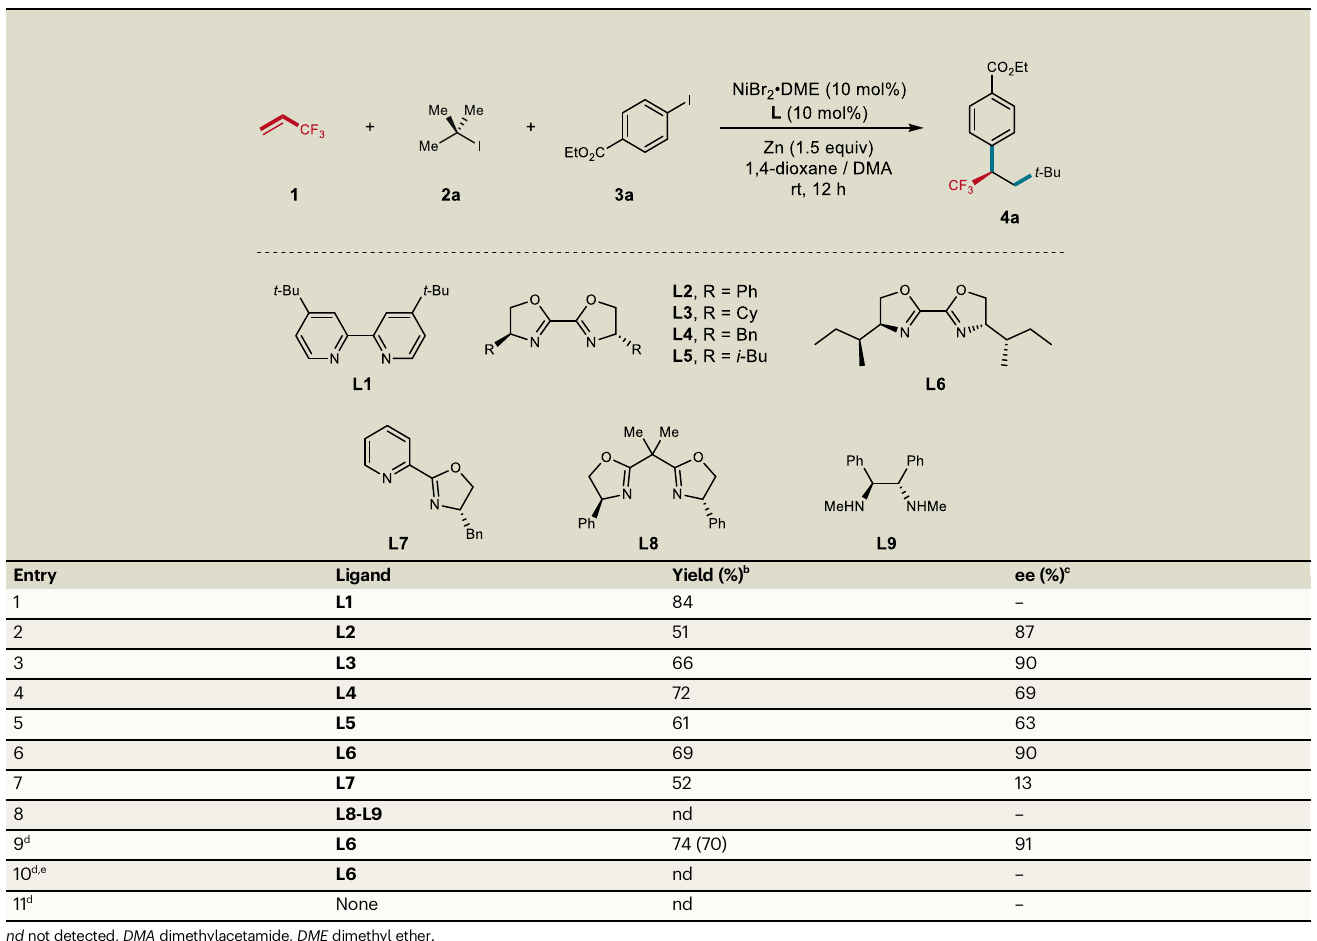
Table 1 | Representative results for the optimization of the reaction conditions